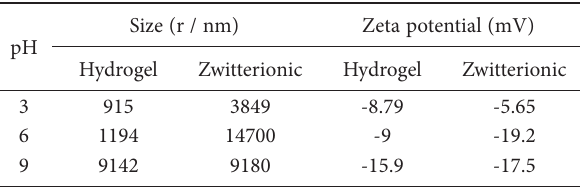
Table 2. Particle size distribution (radius in nm) and zeta poten- tial (mV) of the two polymer resins in different pH solutions. Note that all the samples were prepared in 1mM NaCl solution and pH adjusted using 0.1 M NaOH and 0.1 M HCl solution.